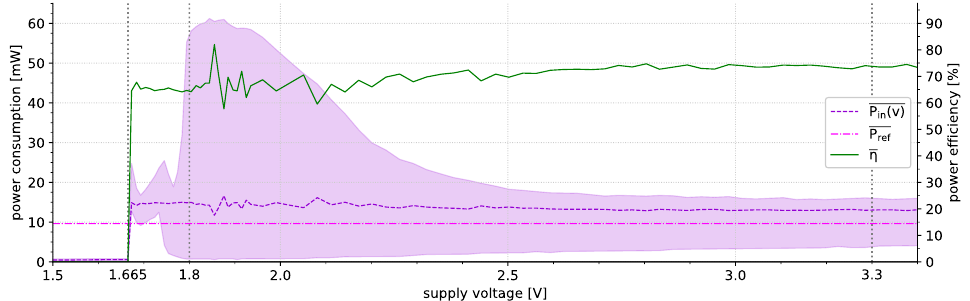
Figure 15. Average power efficiency of the DC/DC